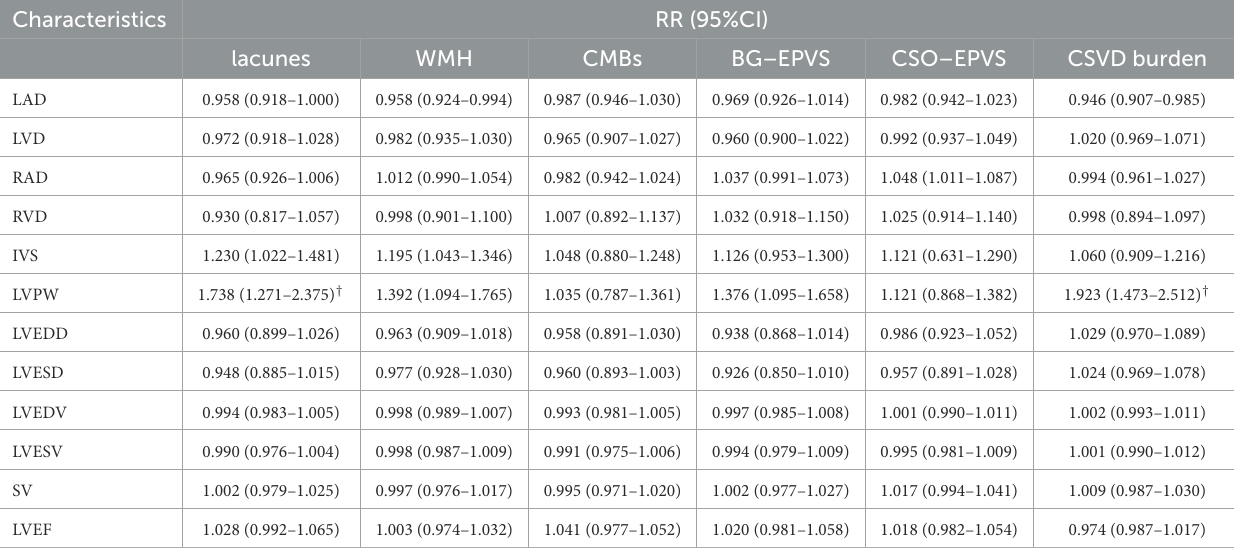
TABLE 3 Univariate analysis for association of echocardiographic parameters with MRI markers of CSVD.